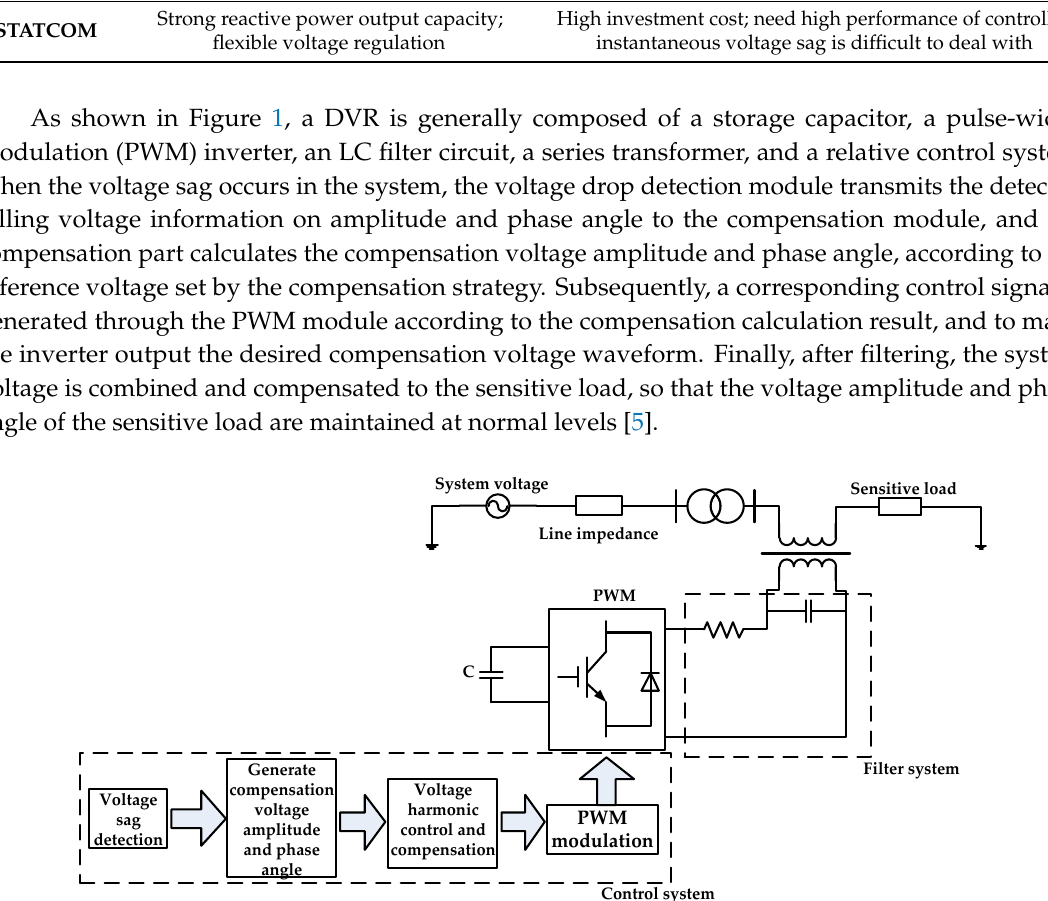
Table 1. Comparison between the main voltage sag compensation devices.